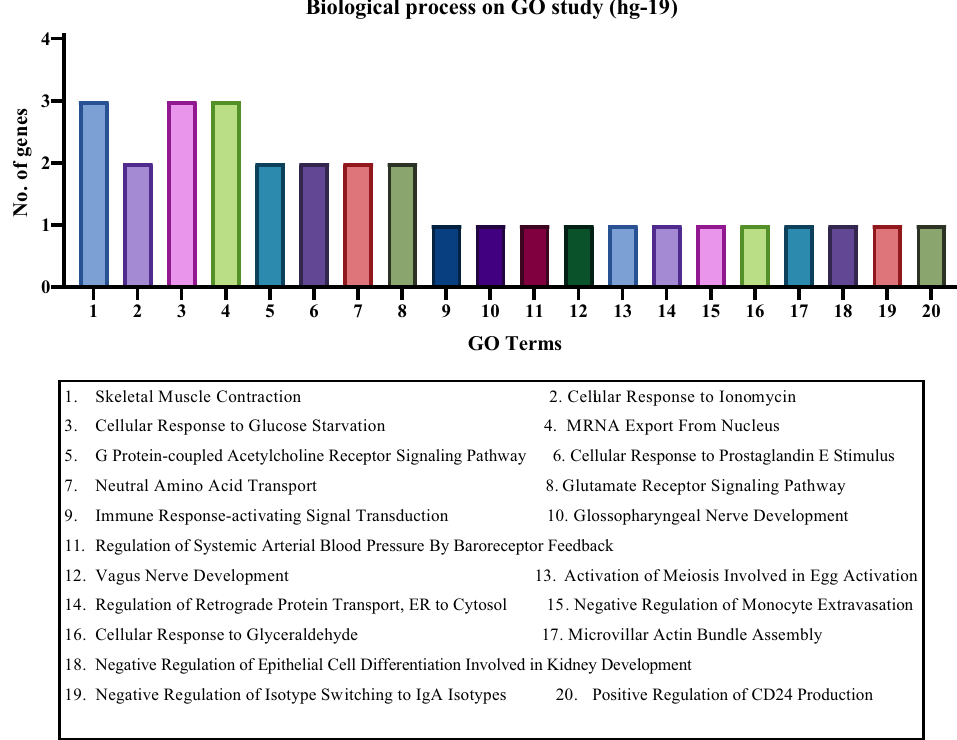
Fig. 8 Biological Process on GO Study (hg-19). The examination of the enrichment of Gene Ontology for the Mural and Cumulus Granulosa Cells. The number of genes that are more prevalent in each biological process is represented along the vertical axis of the bar